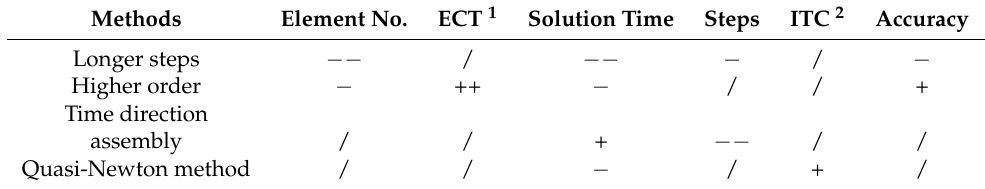
Table 8. Four efficiency increase methods and their effect on efficiency relevant